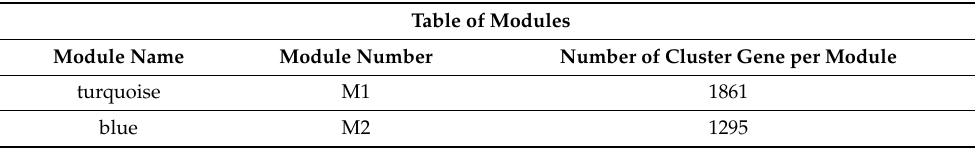
Figure 2. Clustering dendrogram of all expressed genes based on consensus topological overlap with the corresponding module colors and associated clinical traits. The top panel represents the gene dendrogram obtained by clustering the dissimilarity based on consensus topological overlap with the corresponding module colors indicated by the color row. Each colored row (module colors) represents a color-coded module containing a group of highly connected genes. Four biologically significant modules were identified from the 21 modules output from WGCNA. The relationship between each relevant clinical trait was assessed for each color-coded module. Bypassing the default Pearson’s correlation method in WGCNA, we applied biweight midcorrelation as a robust alternative implemented in its WGCNA function ( bicor ). Table 2. Gene networks and their number of genes. The networks are displayed from the largest to small size of